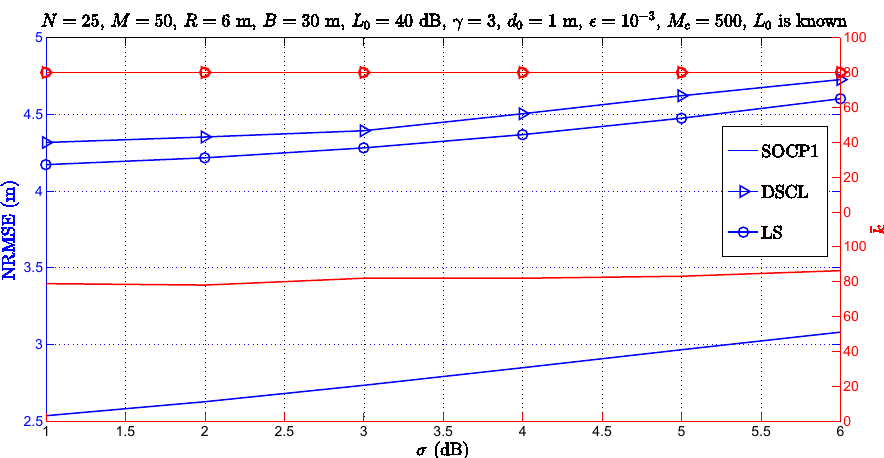
Figure 6. Simulation results for cooperative localization when L versus σ comparison, when N = 25 , M = 50 dB, R = 6 m, B = 30 m, L d = 1 m, K = 100 , (cid:15) = 10 − 3 , M 0 max